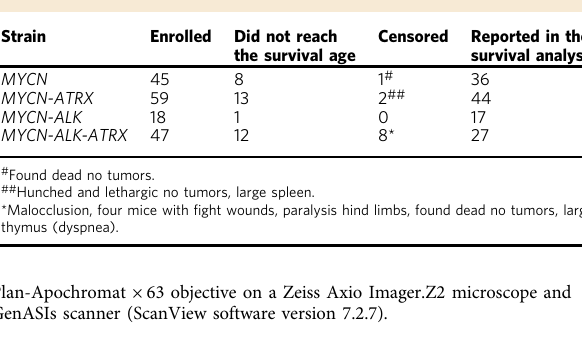
Table 2 Numbers of enrolled mice for neuroblastoma genetic mouse model survival study.